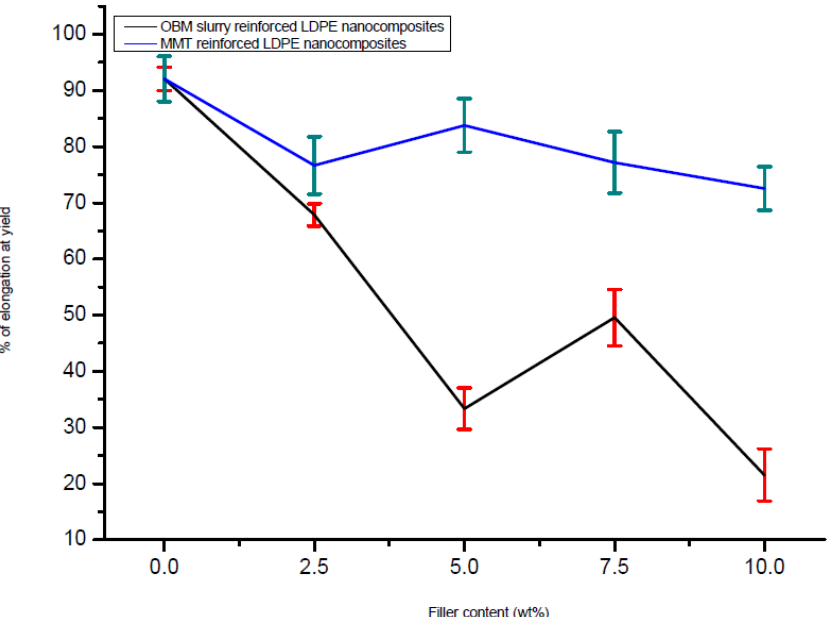
Figure 11. Comparison of elongation (%) at yield of neat LDPE, LDPE/MMT and LDPE/OBM slurry nanocomposites.